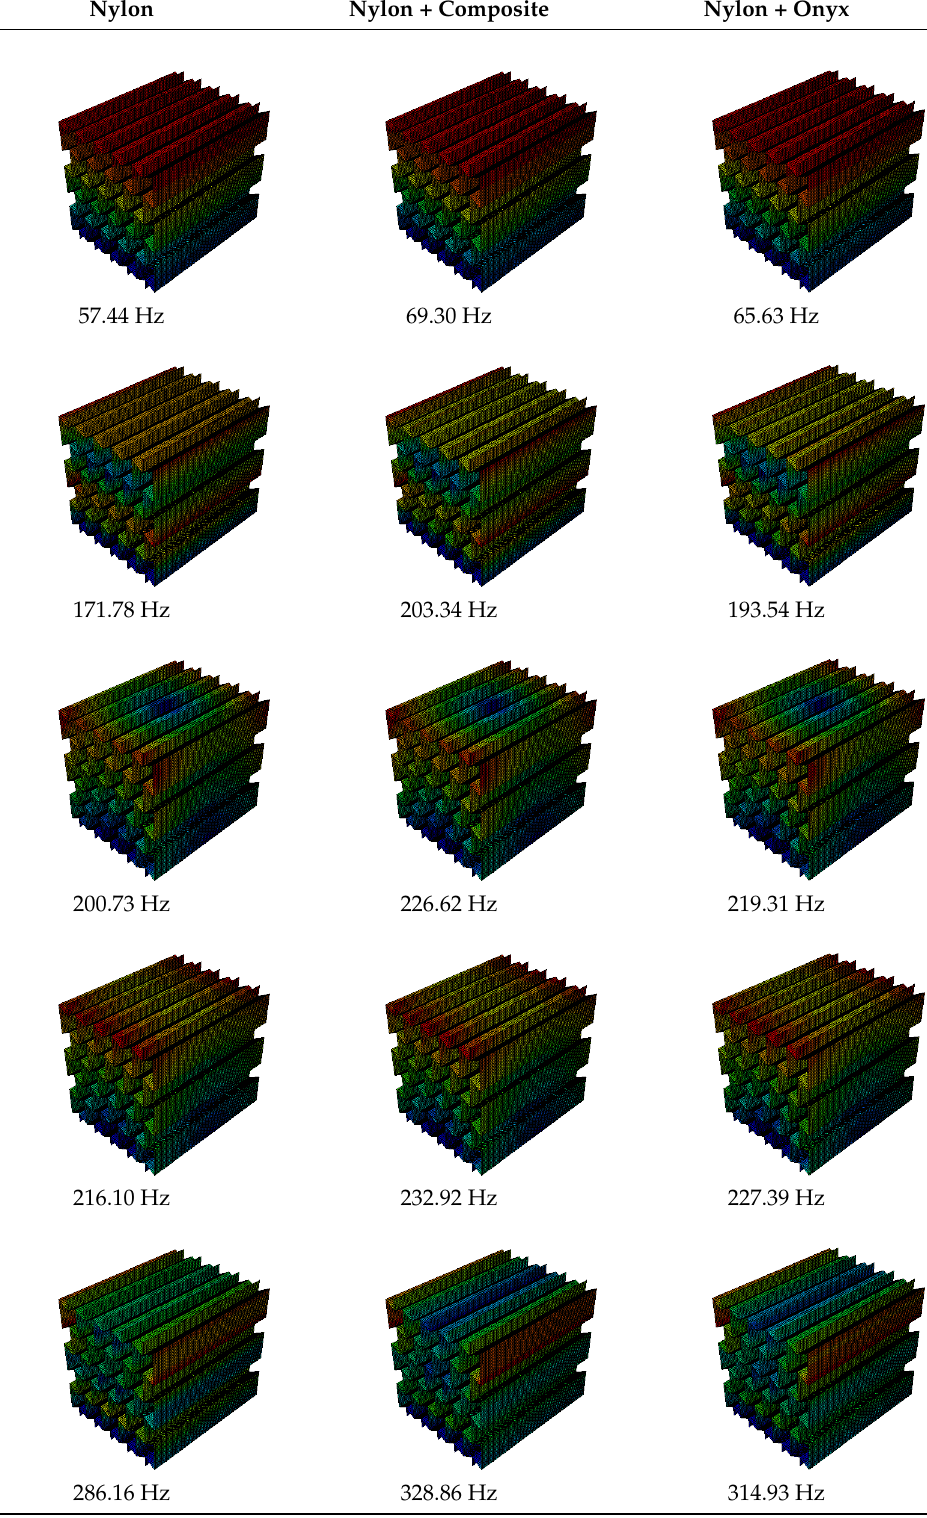
Table 12. First five paired mode shapes of Re-entrant Lattice Structure with top and bottom